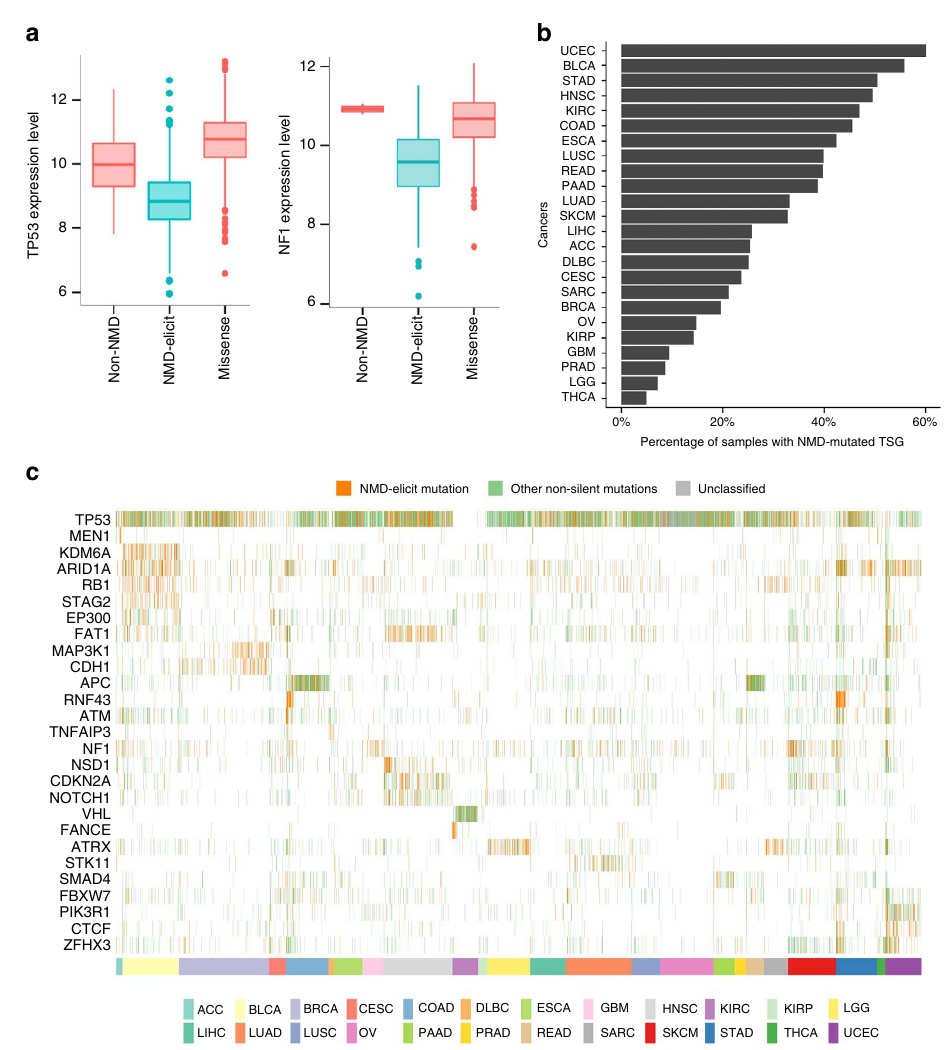
Figure 2 | Tumour type-specific signatures for NMD-elicit mutations in tumour suppressor genes. ( a ) Boxplots showing the expression levels of the indicated genes categorized by the type of mutations. NMD-elicit includes NMD-elicit frameshift insertions/deletions (indels) and nonsense mutations; non-NMD includes frameshift and nonsense mutations that are not NMD-elicit. The genes harbouring NMD-elicit mutations have significantly lower expression than the genes harbouring non-NMD or missense mutations (median ratio of REV ¼ 0.07 for NF1 , 0.06 for TP53 ; P o 2.2e (cid:2) 16, one-side MWW test). The missense is the missense mutation. For TP53 , the numbers in each group correspond to 39, 642 and 1,675. For NF1 , the numbers in each group correspond to 2, 171 and 177. ( b ) A barplot representation of the percentage of samples harbouring NMD-elicit TSGs ( x axis) across cancer types ( y axis). ( c ) A heatmap indicating mutations of genes (rows) across samples (columns) as NMD-elicit (orange), non-NMD-elicit and non-silent (green) or others (grey). Samples were organized by cancer type as indicated in the